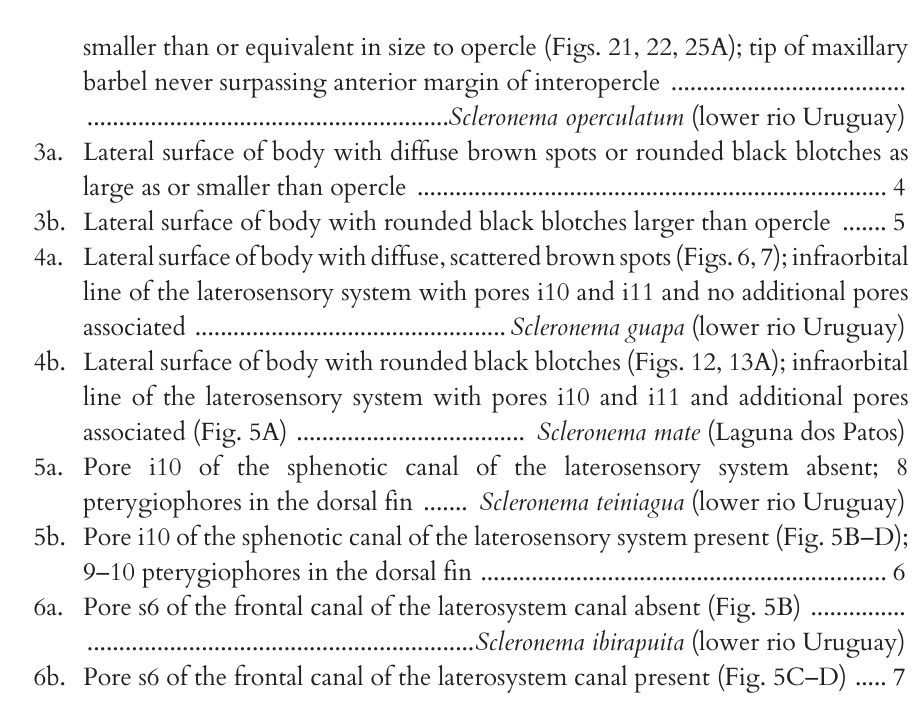
FIGURE 4 | Geographical distribution of the genus Scleronema . Circles and squares indicate species of the S. minutum group and S. operculatum group, respectively. Some symbols represent more than one collection locality. AR = Argentina; BR = Brazil; PY = Paraguay; UY =